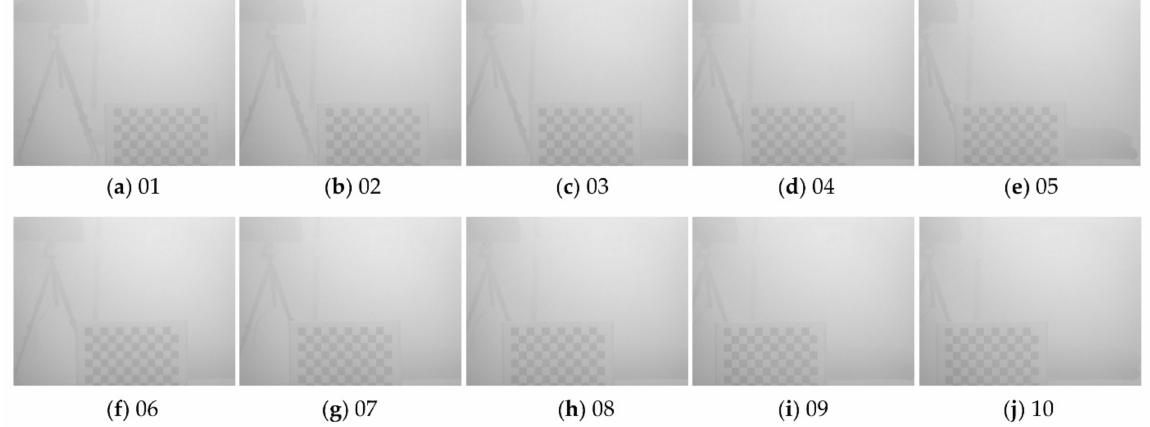
Figure 5. Visible images of the close object from 10 viewpoints.